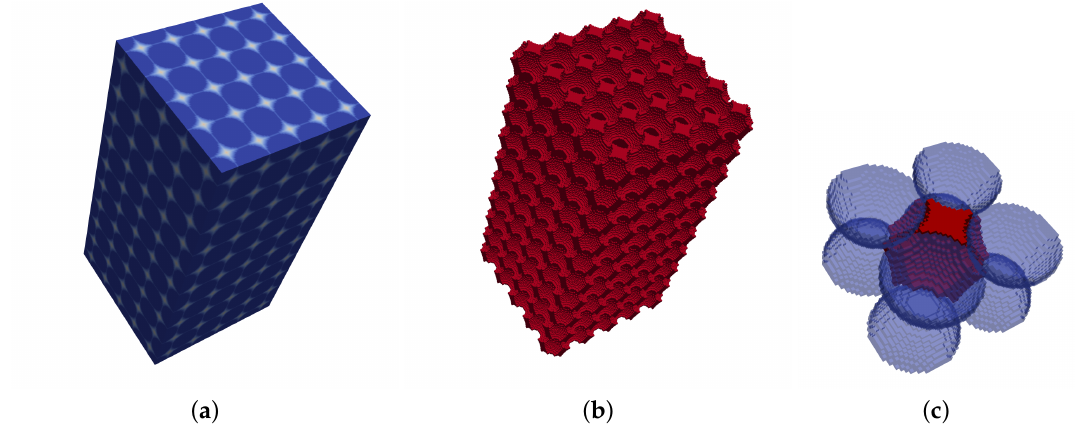
Figure 7. Local void detection in a simple cubic packing. ( a ) EDT representation; ( b ) segmented pore space; ( c ) characteristic local pore.